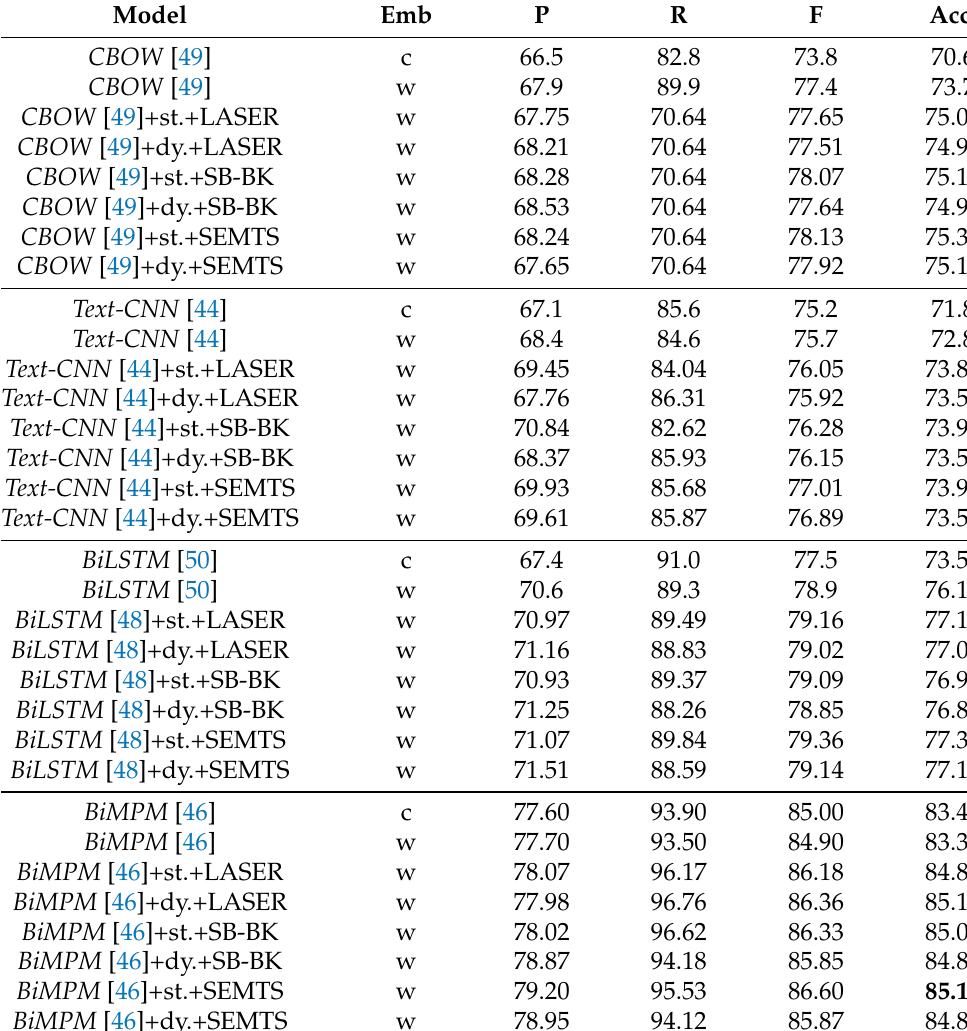
Table 7. The comparison between our method and other models on